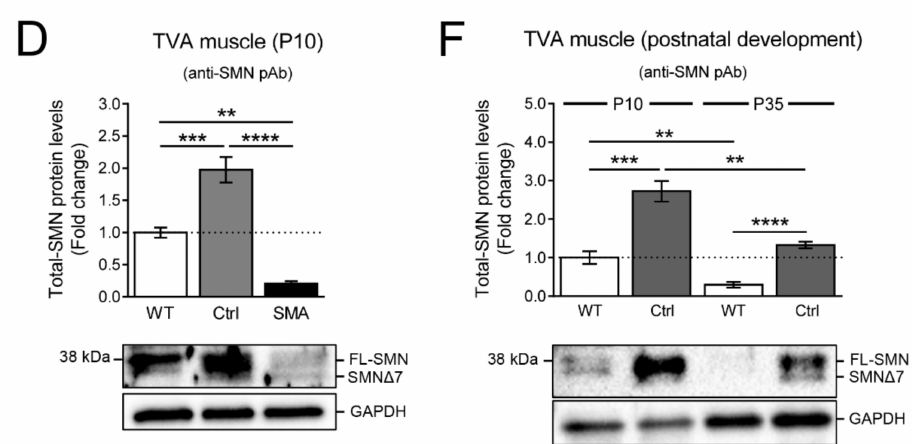
Figure 4. SMN signal was high in motor synaptic terminals of control and SMA mice at P9-10. ( A ). Maximum intensity projections of TVA muscle motor terminals in both genotypes at P9. The motor endplates were identified using BTX-rhodamine labeling (red). Scale bars: 10 µ m. ( B ). Comparison of the SMN area normalized to the postsynaptic area (BTX) in wild-type and SMN ∆ 7 mice (control and SMA). The analysis was performed at P9-10. ***: p < 0.01; n.s.: not significant; ( C , D ). Quantification and representative images of Western blot assays performed on TVA muscle extracts obtained from P10 wild-type (WT) and transgenic SMN ∆ 7 mice (control (Ctrl) and SMA). Either a mouse monoclonal antibody (mAb) anti-SMN or a rabbit polyclonal antibody (pAb) anti-SMN was used in the analysis. Note that with both the anti-SMN mAb ( C ) and the pAb ( D ), total-SMN levels were significantly increased in Ctrl, compared to WT (***: p < 0.001). In contrast, relative expression of total SMN in SMA mice was dramatically reduced compared with either WT or Ctrl animals (****: p < 0.0001 vs. WT